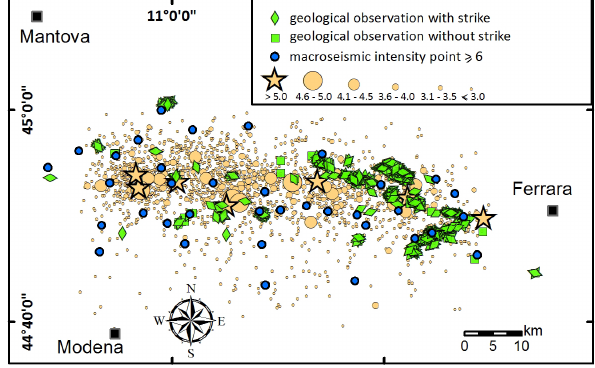
Fig. 9. Map of intensity ≥ 6EMS of the 2012 Emilia sequence (blue circles, modified from Tertulliani et al., 2012), compared with the epicentres (yellow circles) and with the liquefaction pattern (green diamonds and